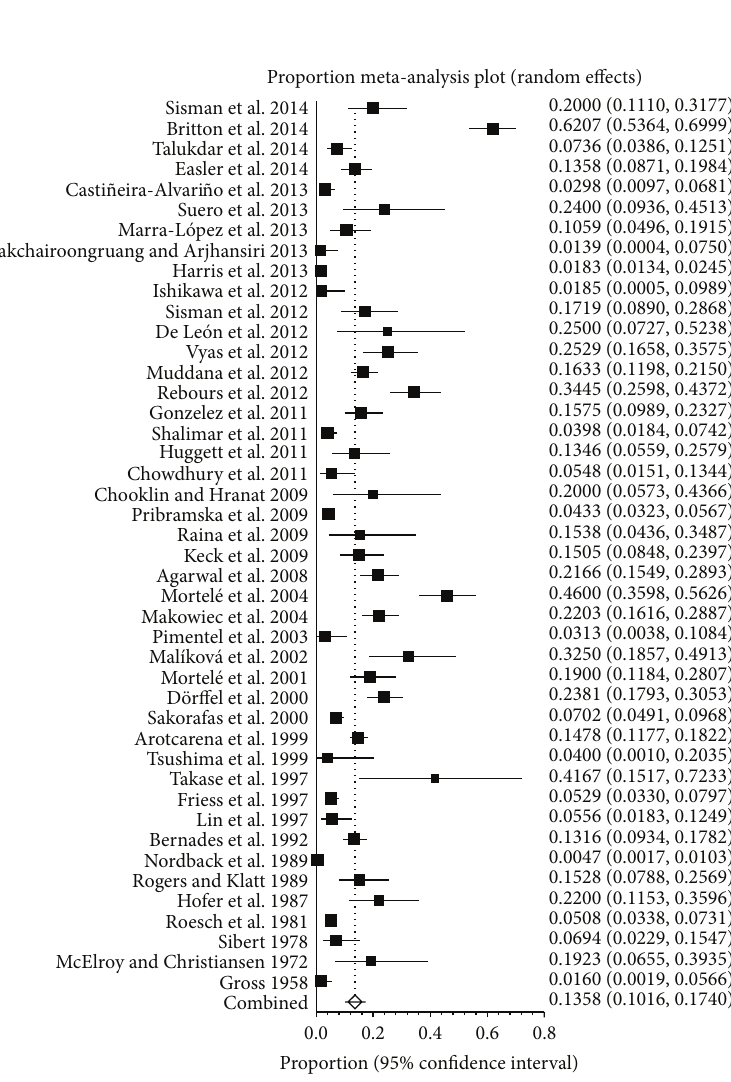
Figure 2: Forest plots showing the prevalence of splanchnic vein thrombosis (SVT) in